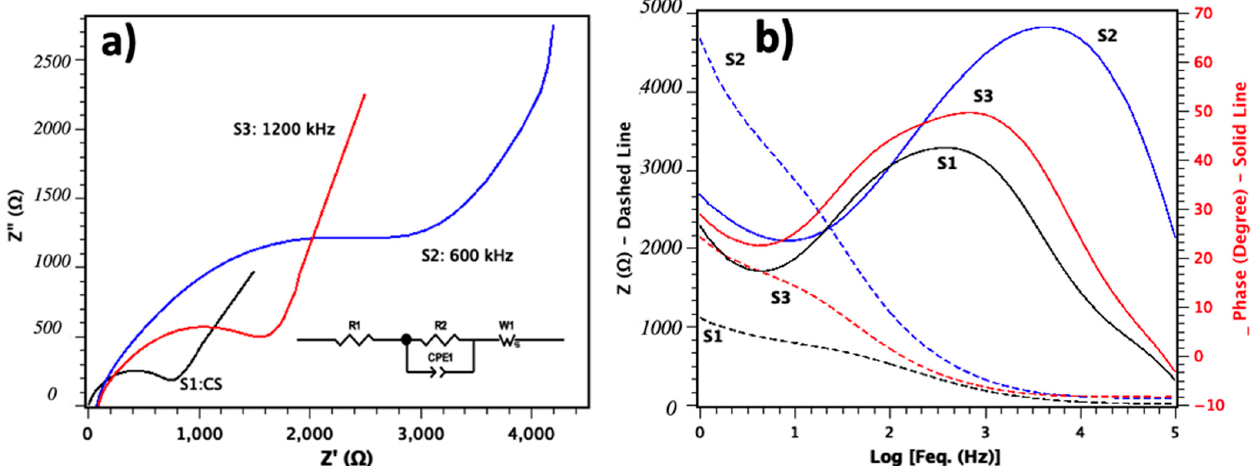
Figure 6. ( a ) Nyquist plots (black: CS, Blue: S2 and Red: S3) and ( b ) Bode plots of S1, S2 and S3 (Z: dashed line, Phase: solid line).